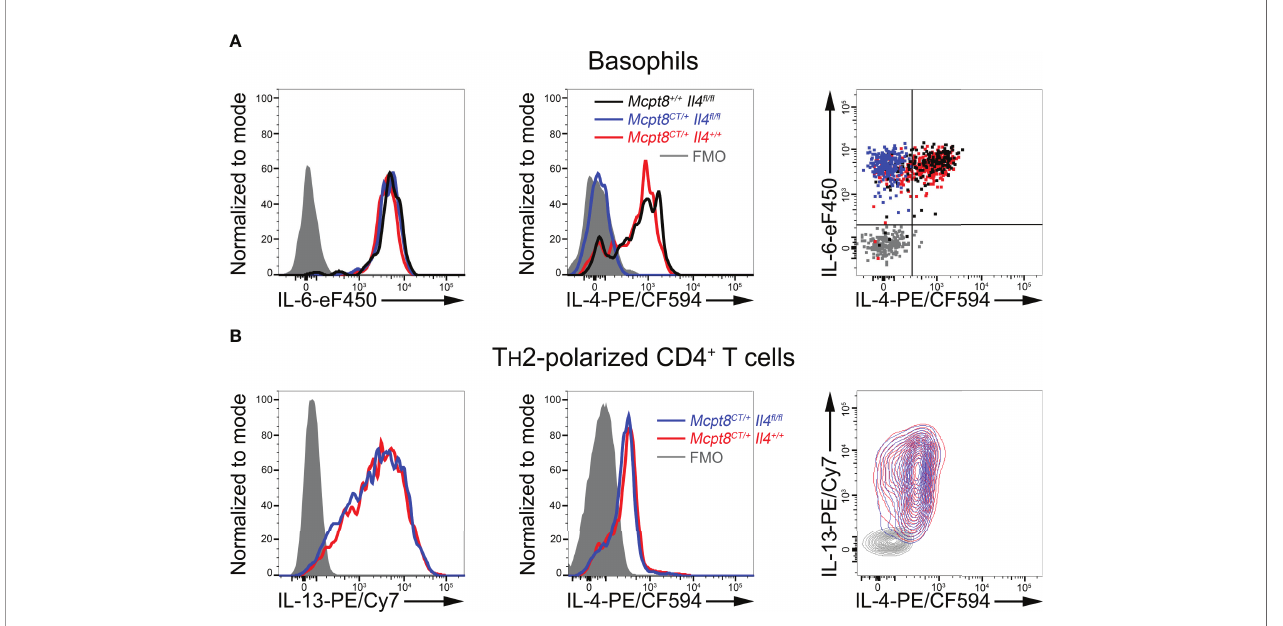
FIGURE 3 | Functional and basophil-speci fi c CRE recombinase expression in CT-M8 mice. (A) Splenocytes from Mcpt8 +/+ Il4 fl / fl (black lines/dots), Mcpt8 CT/+ Il4 +/+ (red lines/dots), and Mcpt8 CT/+ Il4 fl / fl (blue lines/dots) were stimulated for 4 h with PMA and ionomycin in the presence of brefeldin A (see Methods ). IL-6 (left) and IL-4 (middle) productions were assessed in basophils by intracellular fl ow cytometry staining. Productions are also shown together on the right panel as a dot plot. Gray- fi lled histograms and gray dots represent signals from basophils intracellularly incubated with fl uorophore-conjugated isotype controls ( fl uorescence minus one (FMO)). (B) TH2-polarized CD4 + T cells from mice with the indicated genotypes (see Methods ) were stimulated with PMA and ionomycin for 4 h in the presence of brefeldin (A) Productions were assessed by intracellular staining of IL-13 (left) and IL-4 (middle). Productions are also shown together on the right panel as a contour plot. (A, B) Representative data from one mouse per genotype are shown. A minimum of 3 mice per genotype were analyzed, showing similar